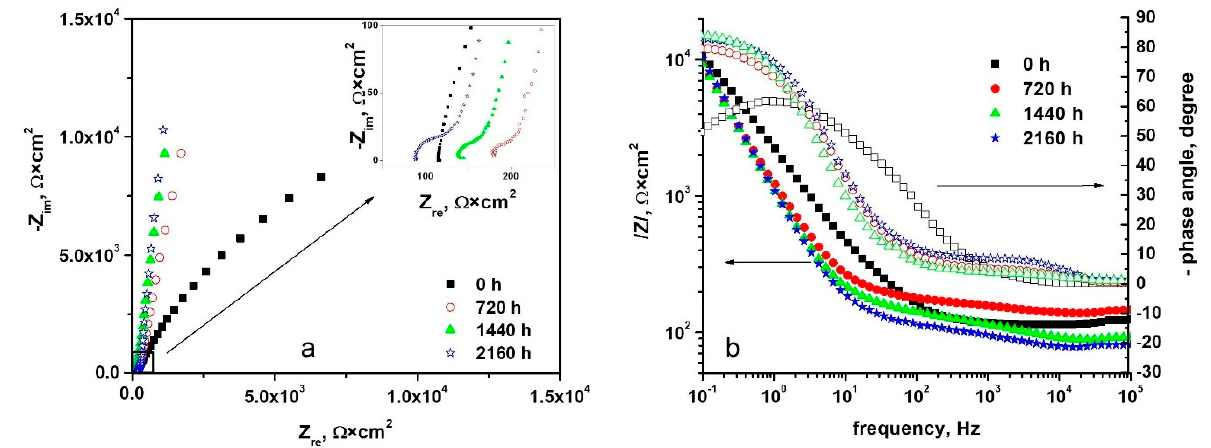
Figure 7. Nyquist ( a ) and Bode ( b ) diagrams for the CrN x -coated 310 H SS samples before and after oxidation in water at 550 °C and 25 MPa.